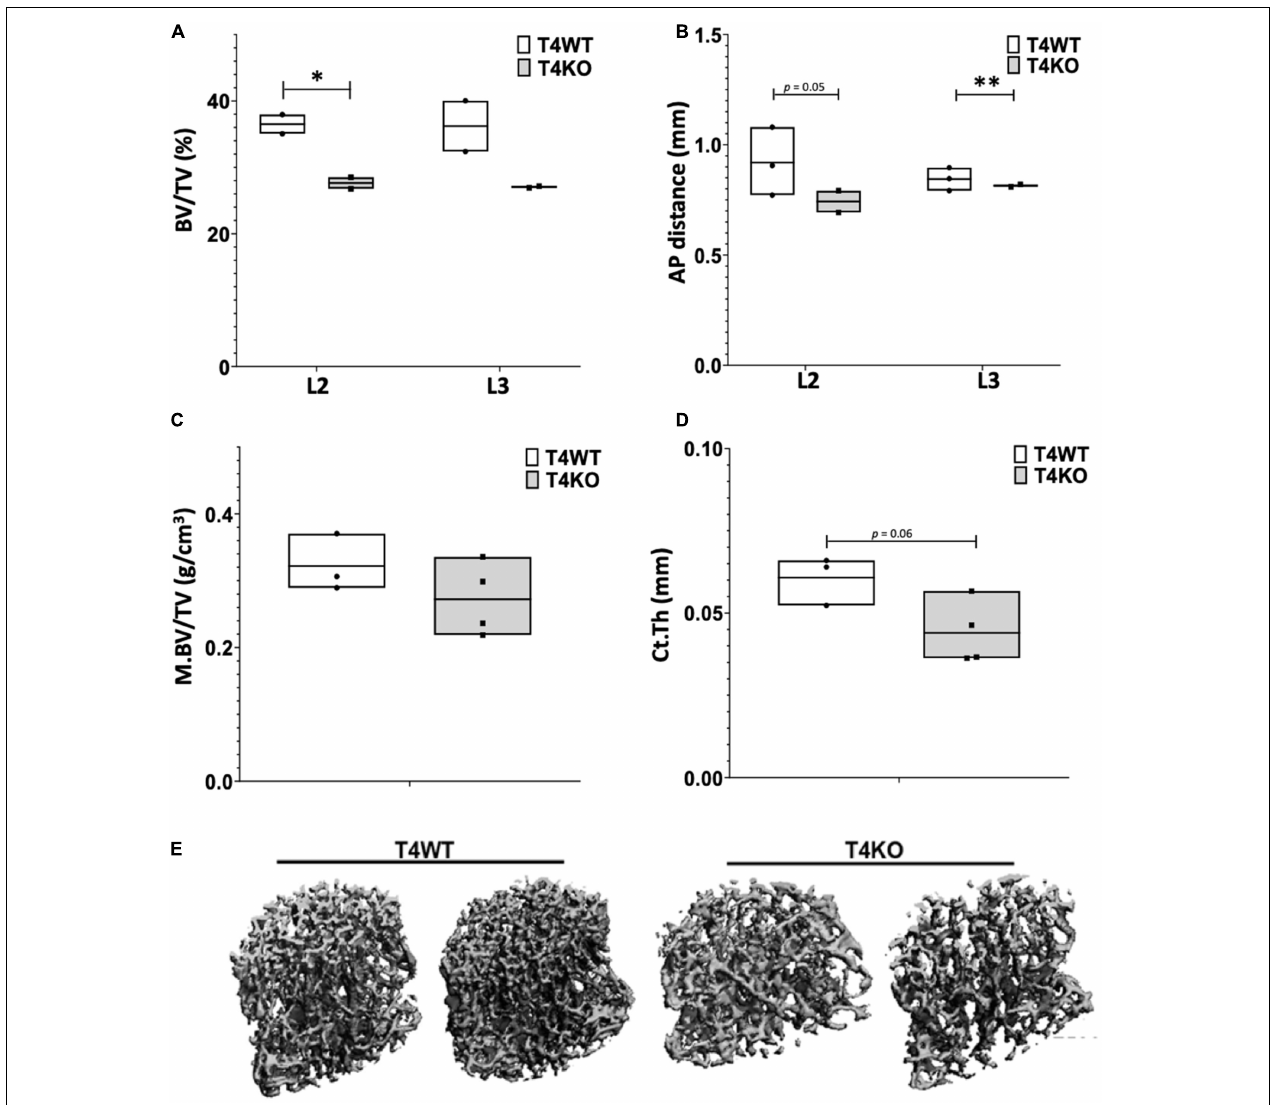
FIGURE 1 | T4KO mice exhibit deficiencies in bone formation. MicroCT measurements of (A) BV/TV and (B) AP distance in L2 and L3 vertebrae of T4KO and T4WT littermates demonstrate decreased bone density and spinal canal diameters ( n = 2 biologic duplicates per arm; ∗ p < 0.05, ∗∗ p < 0.01, Student t -test). Femurs collected from 9-day old T4KO and T4WT littermates were analyzed for (C) medullary bone density and (D) cortical thickness. Both measurements show decreased trend in T4KO vs. T4WT mice ( n = 3–4 mice per arm, technical duplicates). (E) MicroCT image reconstructions of trabecular bone in L3 vertebrae of 3-to-4 weeks old T4WT and T4KO mice, illustrating decreased bone density and trabecular bone formation in Tle4 null mice ( n = 2 biologic duplicates per